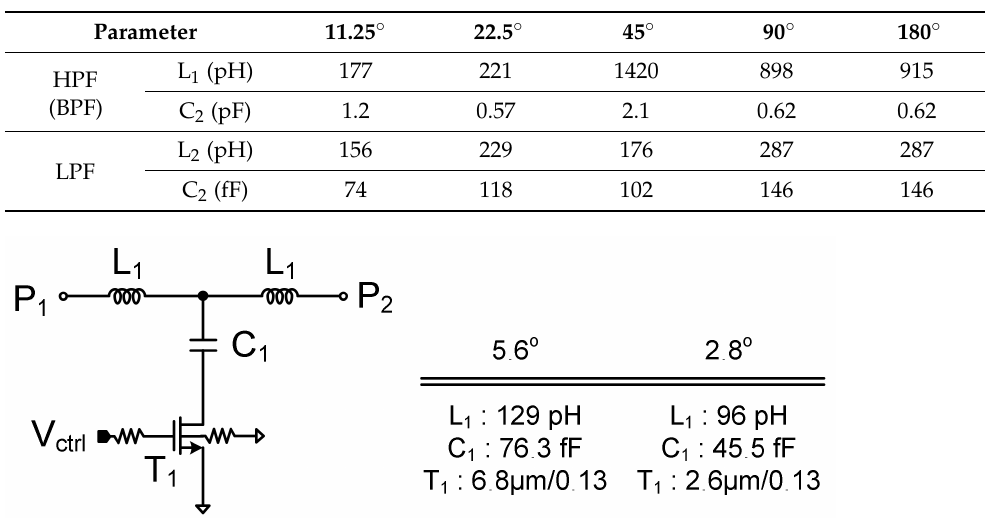
Figure 4. Schematics of the phase shifting elements of ( a ) 11.25 ◦ and 22.5 ◦ , ( b ) 45 ◦ and 90 ◦ , ( c ) 180 ◦ . Table 1. Design parameters of the phase shifting filter networks.